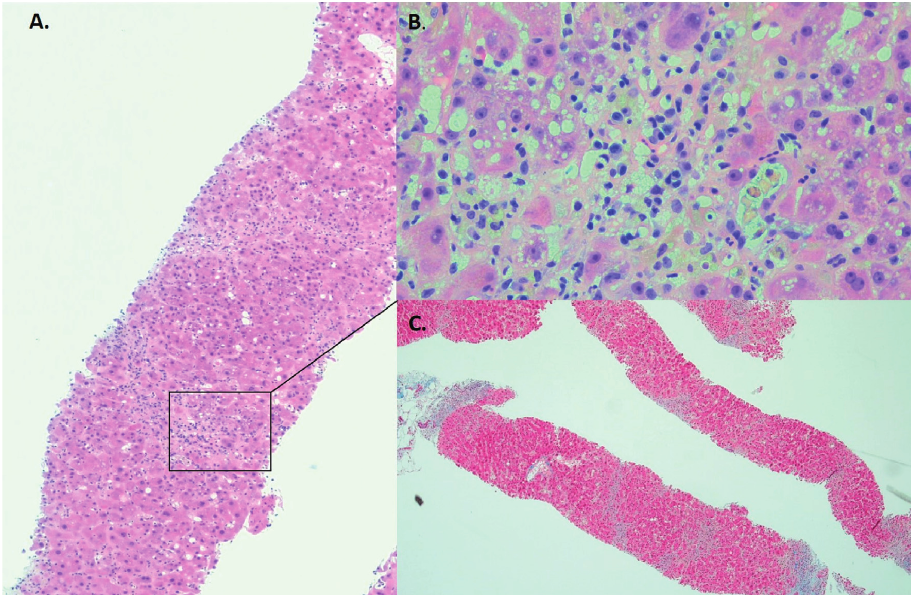
Figure 1: (a) Liver biopsy (H&E, x40) showing bridging necrosis and collapse of parenchyma with cholestasis and sparse inflammatory infiltrate rich in lymphocytes and plasma cells ((b) inset x200). (c) A trichrome stain (x20) showing lack of fibrosis supporting acute nature of the illness.